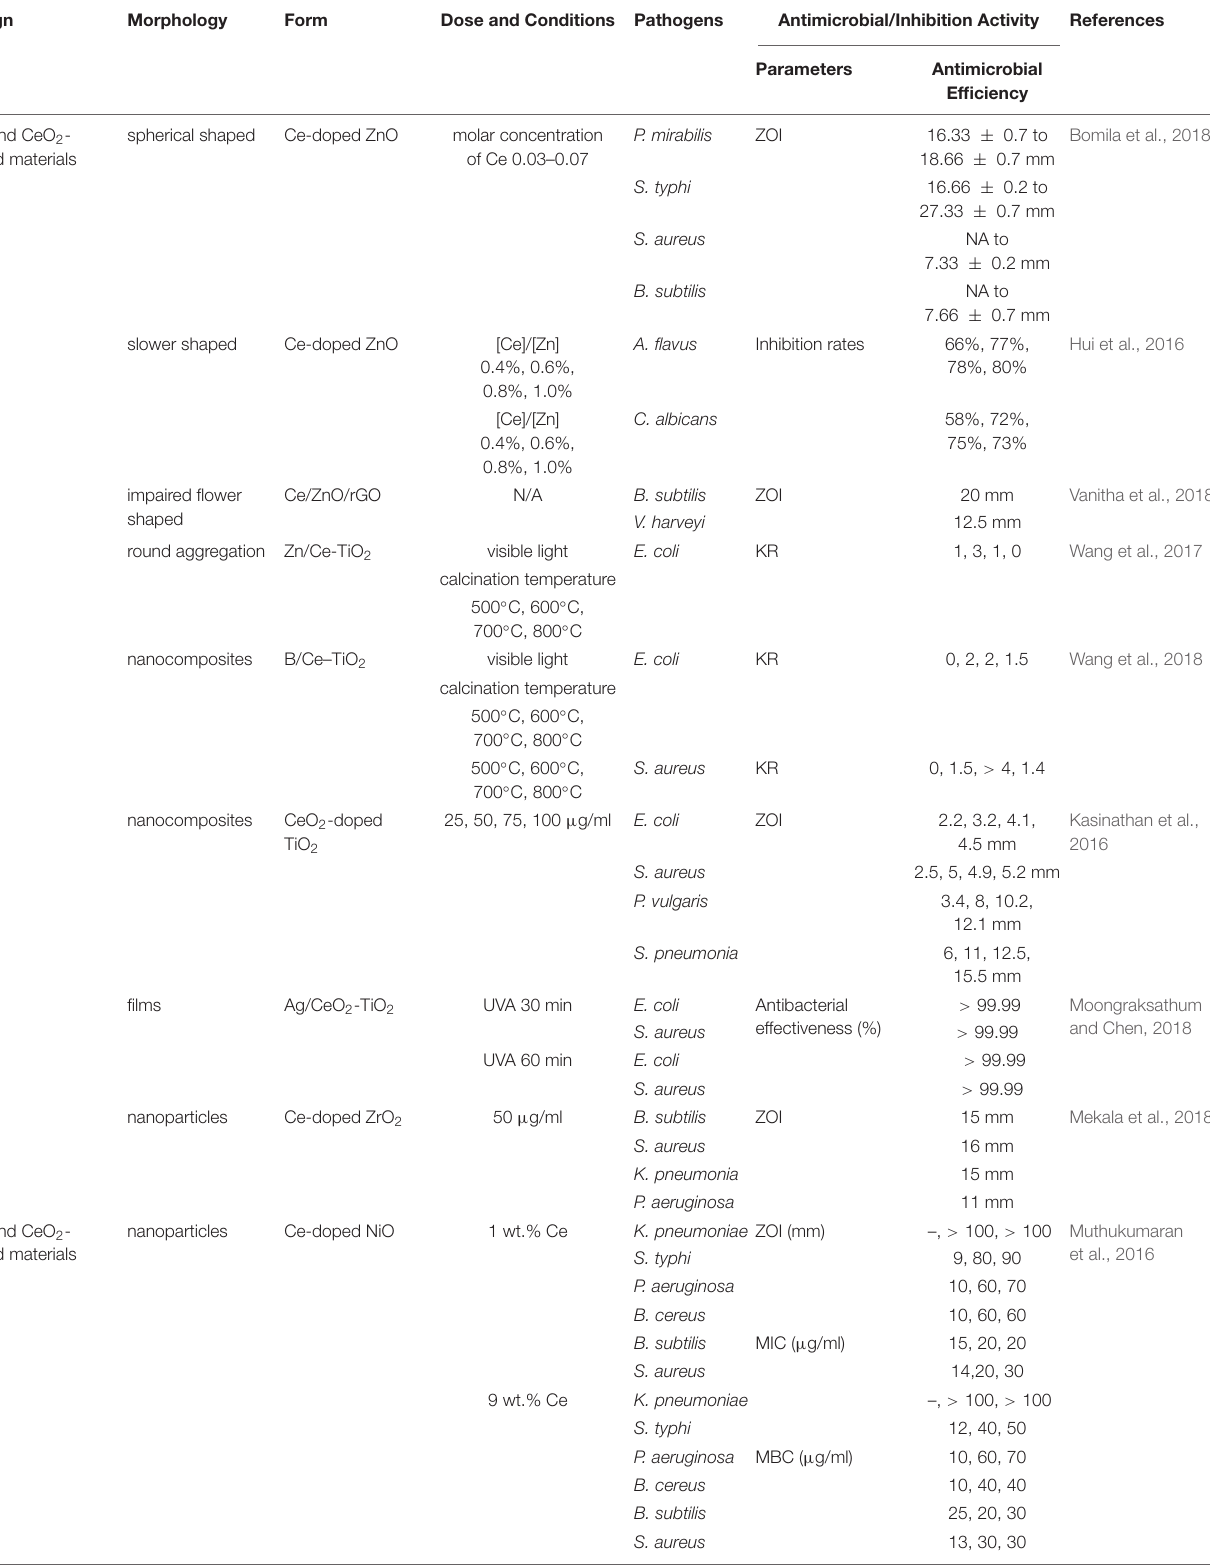
TABLE 3 | The antimicrobial activities of cerium- and cerium oxide-doped materials.